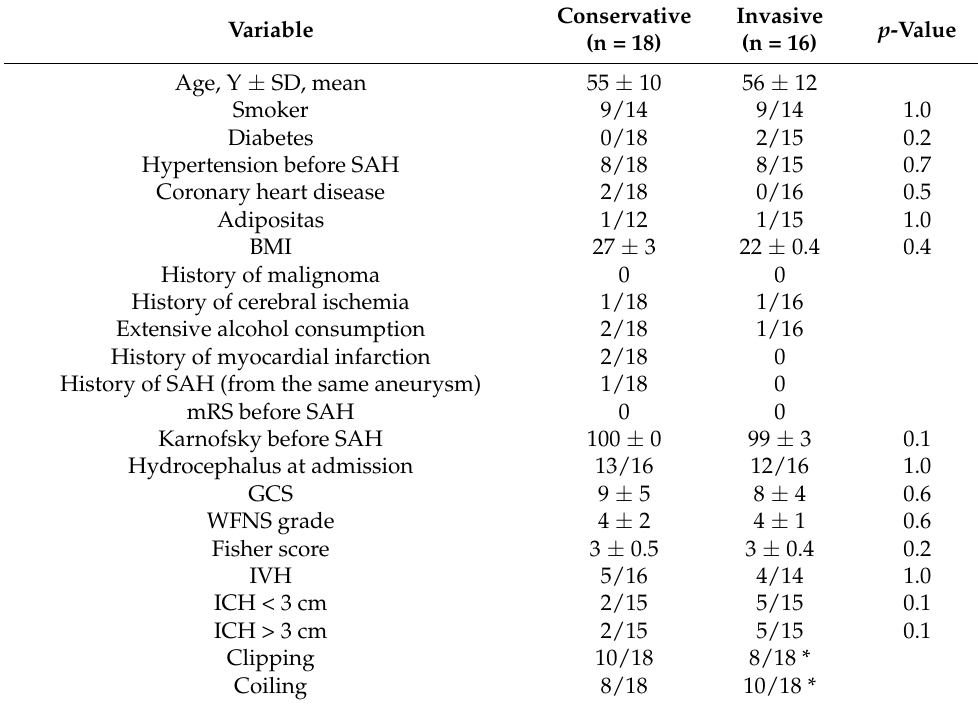
Table 1. Patient